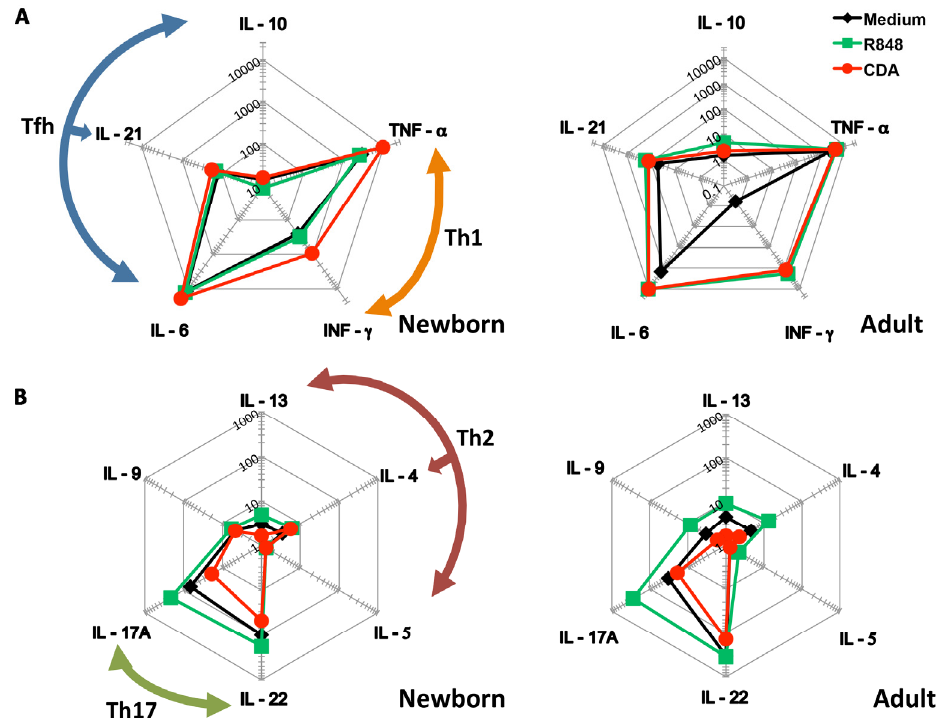
Figure 1. Adjuvant elicited T helper cytokine profiles on human newborn and adult blood. Human cord blood was used as a neonatal blood surrogate in vitro. Cord blood and human adult blood controls were diluted 1:1 with RPMI 1640 and incubated for 6 h in the presence of the neonatal gold standard adjuvant R848 (3.5 µg/mL/10 µM), CDA (5 µg/mL/7.6 µM), and medium control. Spider plots display cytokine values in pg/mL in supernatants of treatments for ( A ) IL-10, IL-21, and IL-6 (T follicular helper profile, Tfh), TNF- α and IFN- γ (Th1); and ( B ) IL-17 and IL-22 (T helper 17, Th17), IL-4, IL-5, and IL-13 (T helper 2, Th2) in cord blood (newborn) or adult blood. Results correspond to one out of two independent